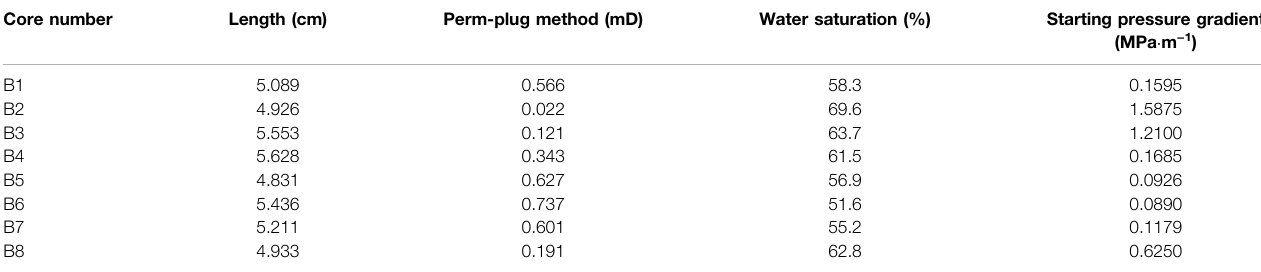
TABLE 1 | Oil phase starting pressure gradient under different water saturations.